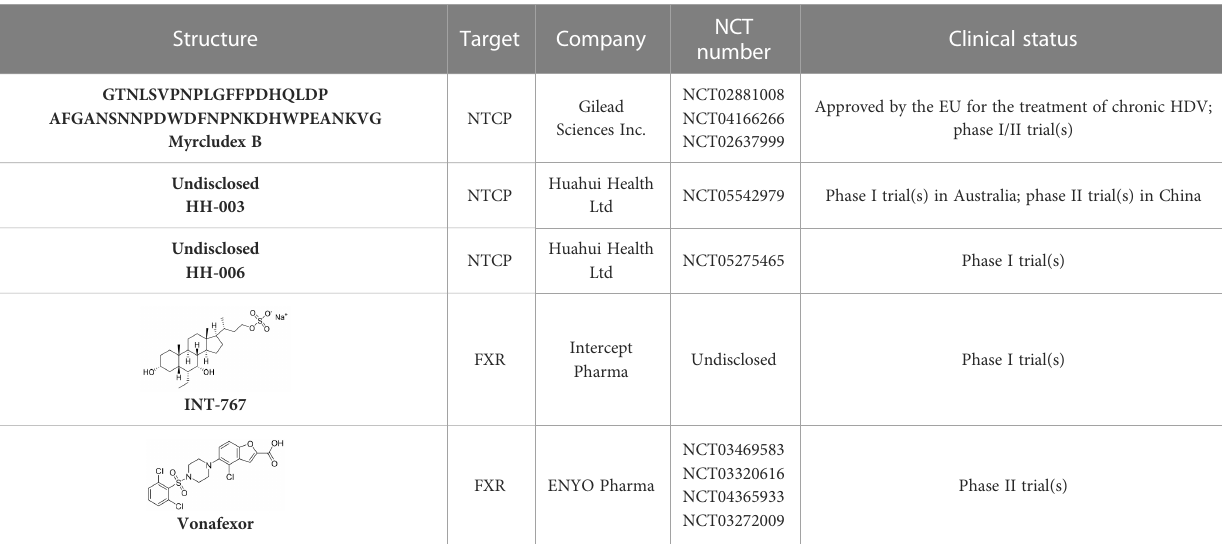
TABLE 1 Summary of molecules as entry